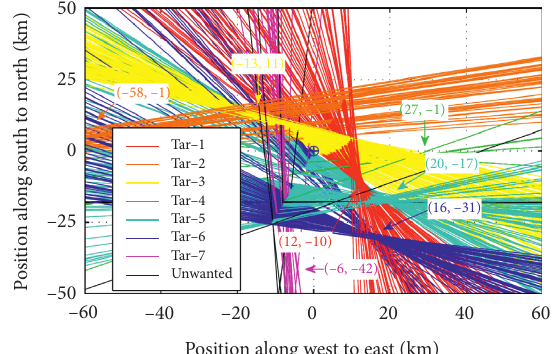
Figure 15: Initial position equation map with measured data.